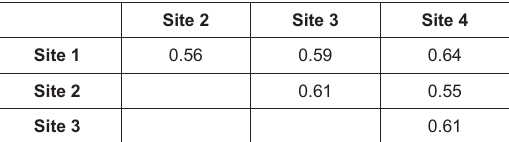
Table 2. Sorensen’s index representing the similarity values between study sites in Dalma Wildlife